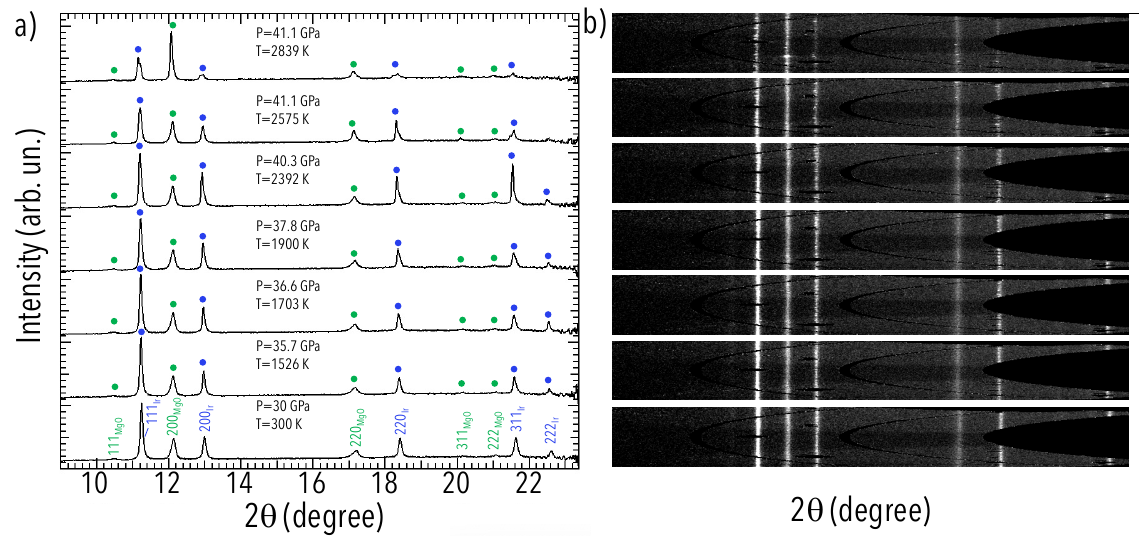
Figure 3. Selection of XRD patterns showing the ( a ) structural and the corresponding ( b ) textural evolution of an Ir sample embedded in MgO PTM between ambient T and 2900 K, in a pressure range between 30 GPa and 41